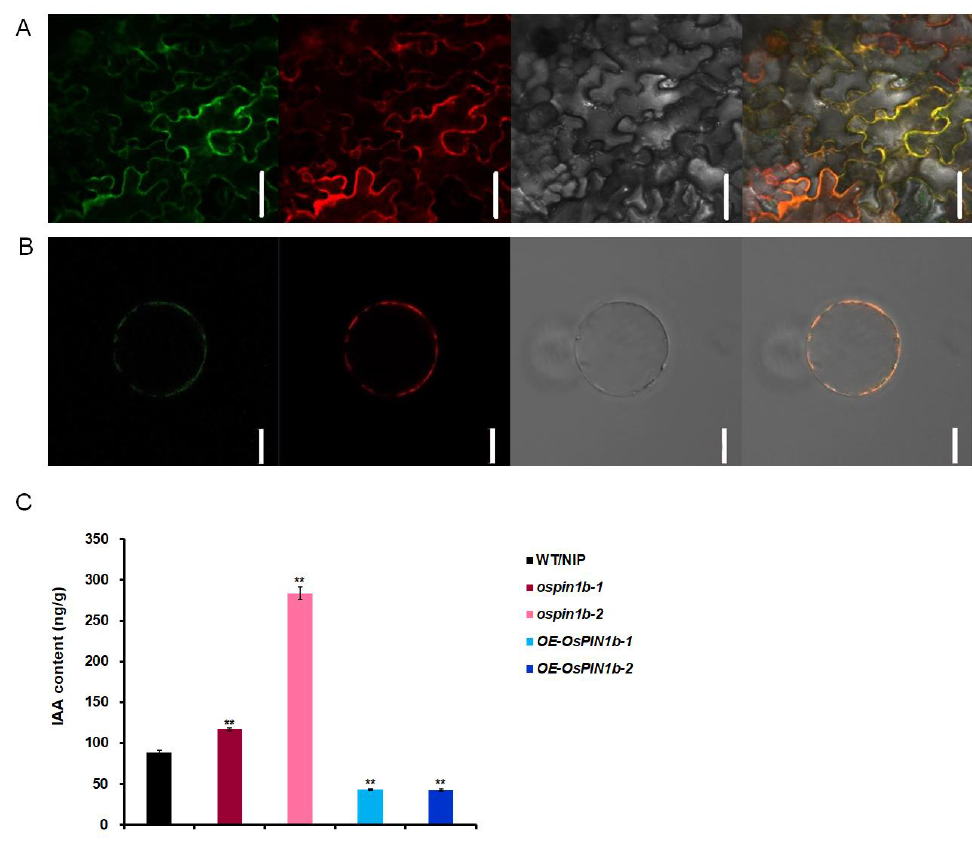
Figure 4. Subcellular localization of OsPIN1b and auxin contents in lamina joints. ( A , B ) 35S:OsPIN1b-sGFP fusion construct and plasma membrane marker pm-rb CD3-1008 were simultaneously co-expressed in Nicotiana benthamiana epidermal cells (upper) and rice protoplasts (lower). From left to right, represents green fluorescence of 35S:OsPIN1b-sGFP , red fluorescence of membrane marker pm-rb CD3-1008 , bright-field images, and yellow merged fluorescence, respectively. Scale bars = 10 μm. ( C ) Auxin contents in lamina joints of 7-day-old WT/NIP, ospin1b-1, ospin1b-2, OE-OsPIN1b-1, and OE-OsPIN1b-2 . The three biological repeats were used in these experiments. The data are mean ± SD (n = 3) and asterisks indicate the significant differences in the above-mentioned lines (** p < 0.01; Student’s t -test).